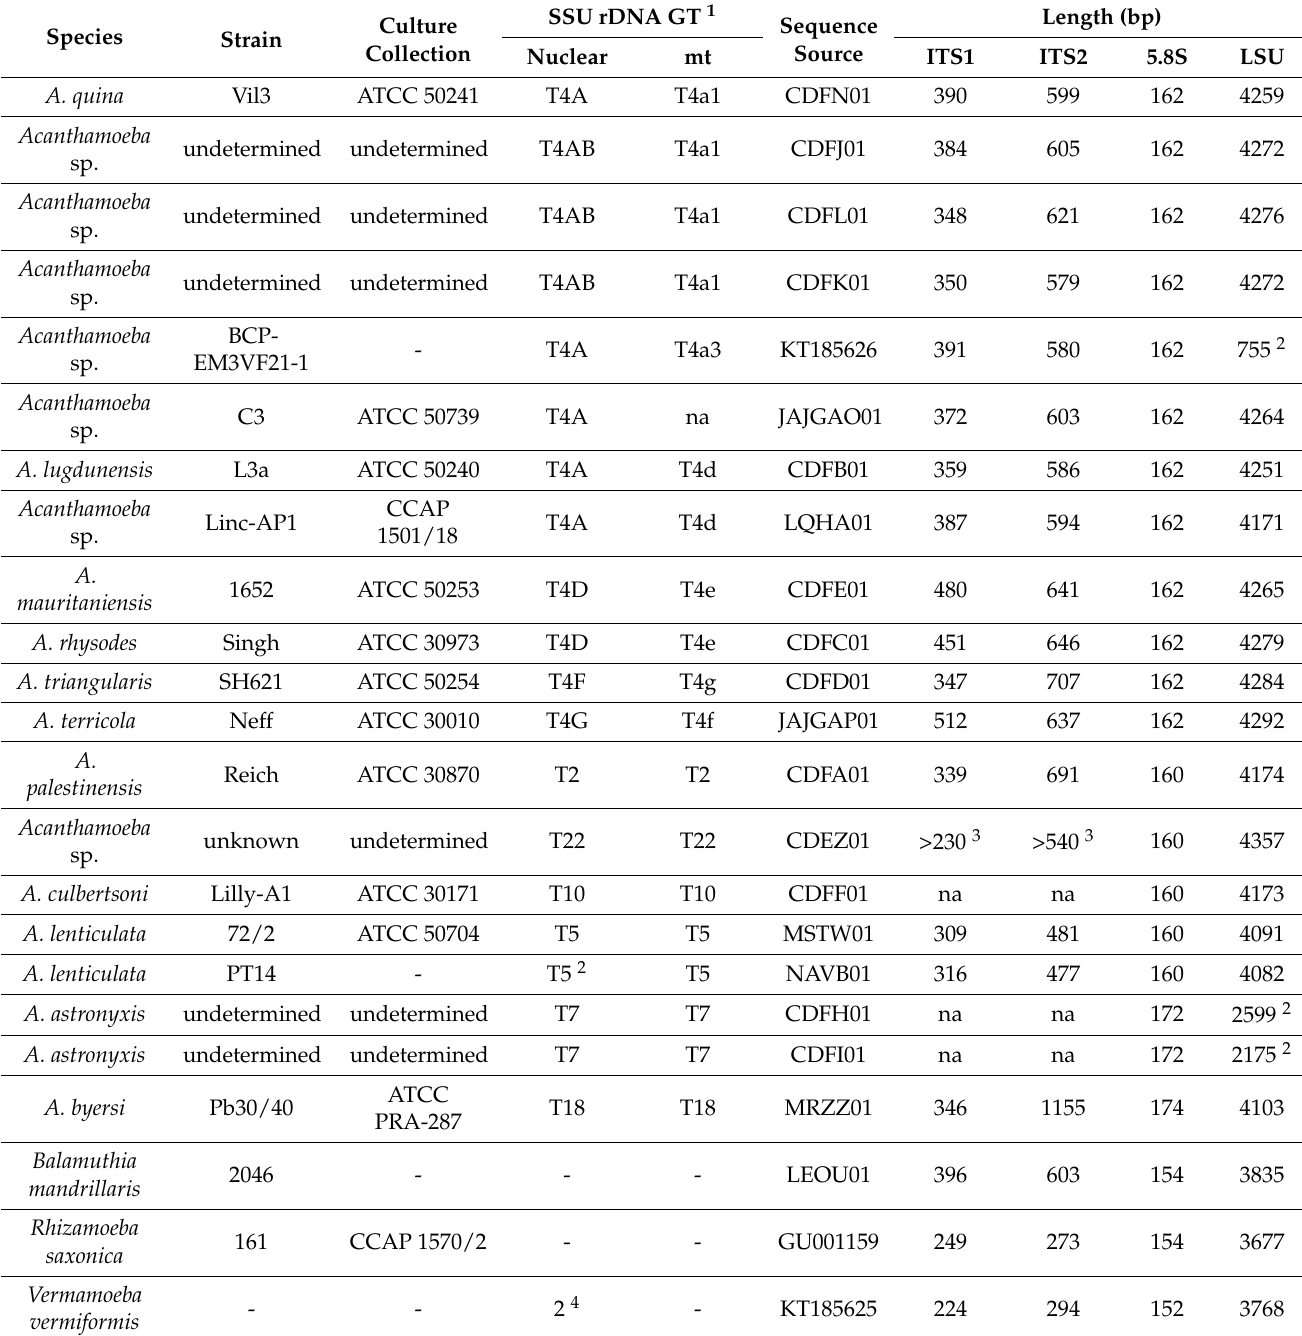
Table 1. Summary of the ITS and LSU sequence